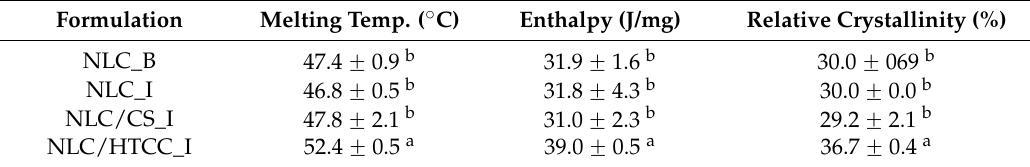
Table 3. Melting parameters and relative crystallinity of indomethacin loaded NLC formulations. Formulation